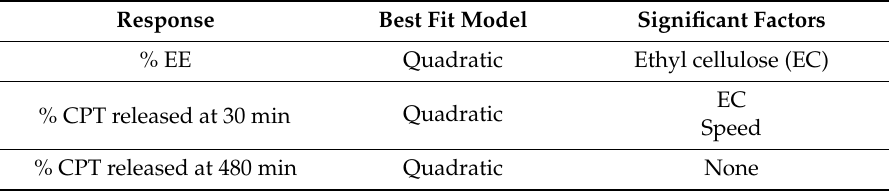
Table 5. Summary of responses and the best fit models and significant input factors.